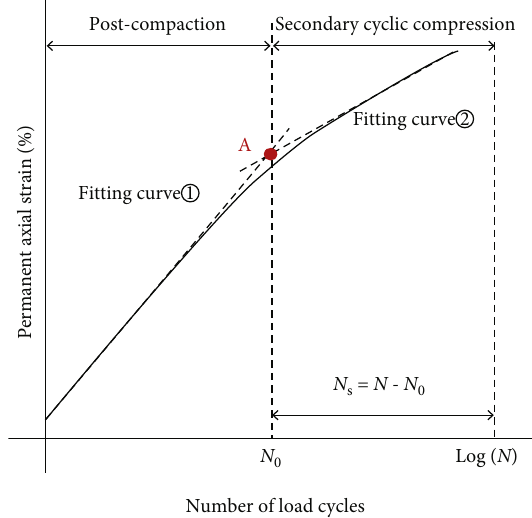
Figure 9: Determination of critical load times.